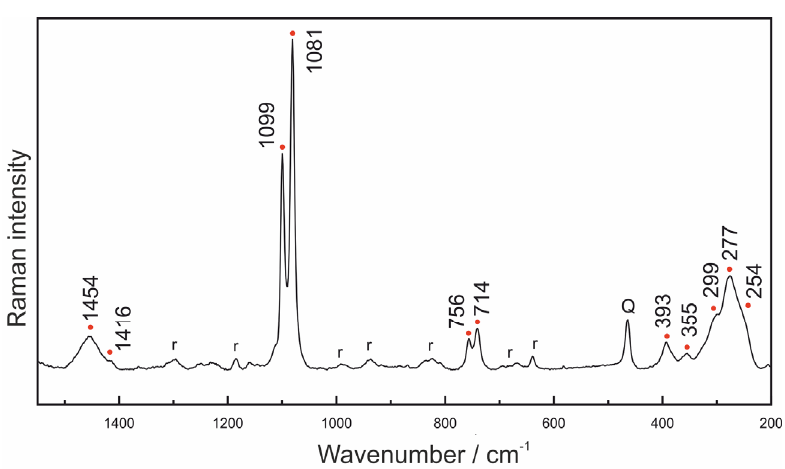
Figure 8. Raman spectrum of synchysite-(Ce) between 200 and 1550 cm − 1 . Bands labeled with (Q) belong to quartz, and bands labeled with (r) belong to a synthetic resin from a thin section.